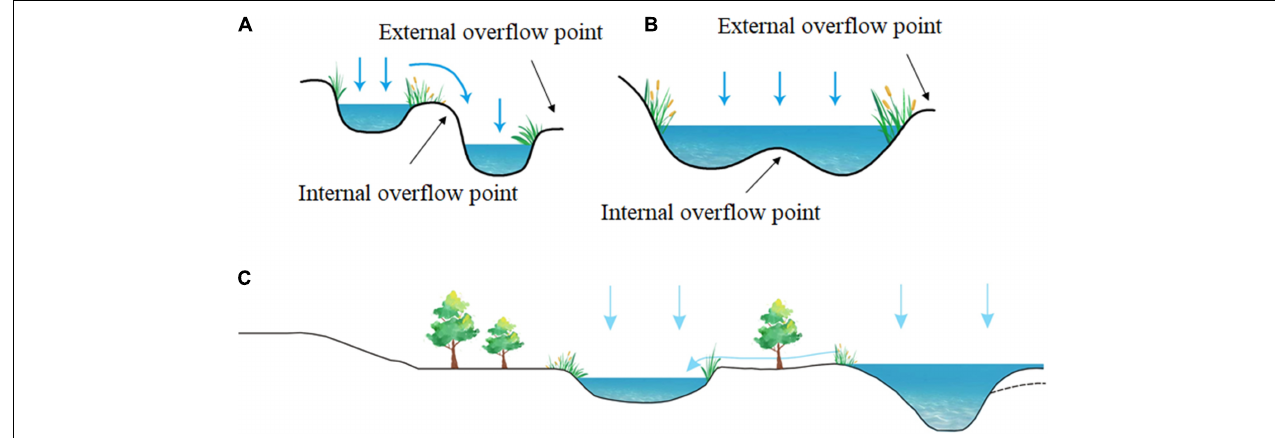
FIGURE 11 | Mechanisms and types of surface hydrodynamic process ( A . fill-spill; B . fill-merge; and C . river-floodplain connections).